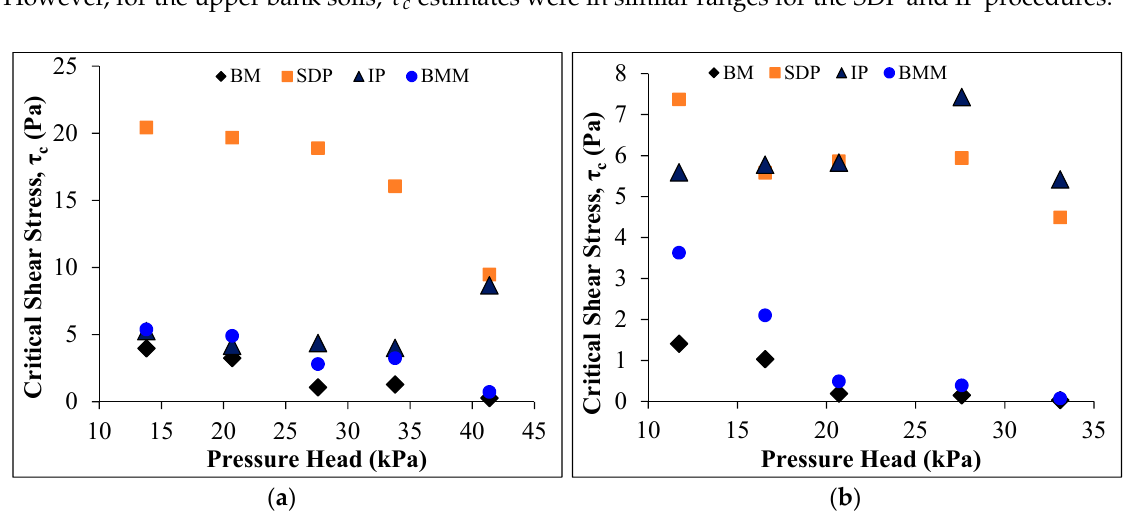
Figure 3. Using the SPS method, estimates of critical shear stress ( τ c ) with different pressure heads are shown for the: ( a ) lower bank and ( b ) upper bank, based on the following computational procedures: BM = Blaisdell method, IP = iterative principle, SDP = scour depth principle, and BMM = modified Blaisdell method.